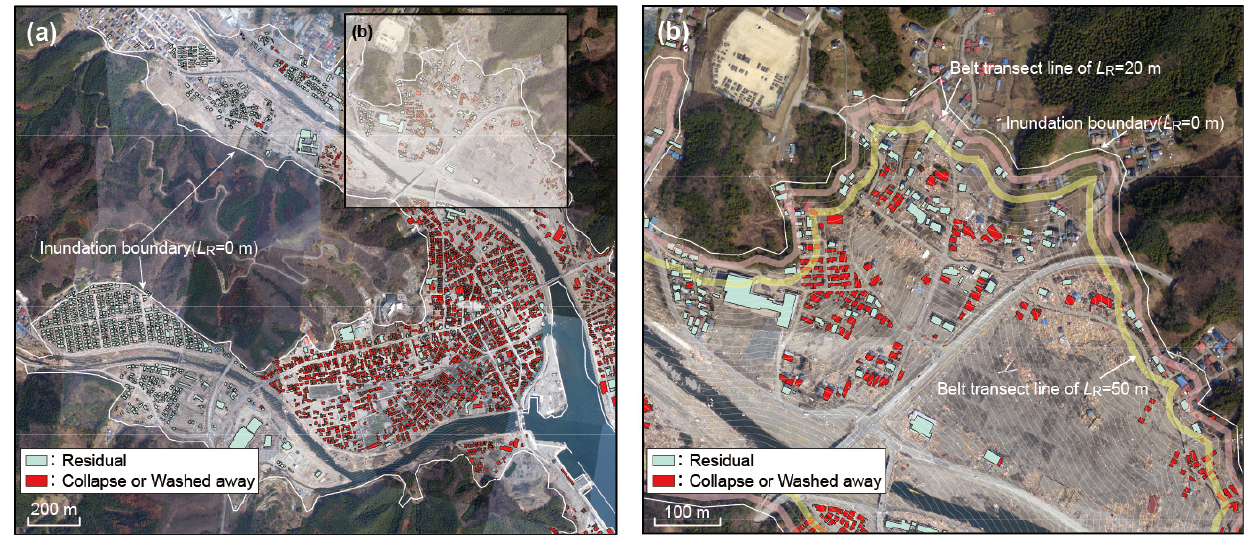
Figure 4. ( a ) Distribution of damage in the inundated area of Otsuchi area A. ( b ) A portion of the inundated area showing belt transects in relation to the tsunami inundation boundary. Each figure from Imai et al. [6].